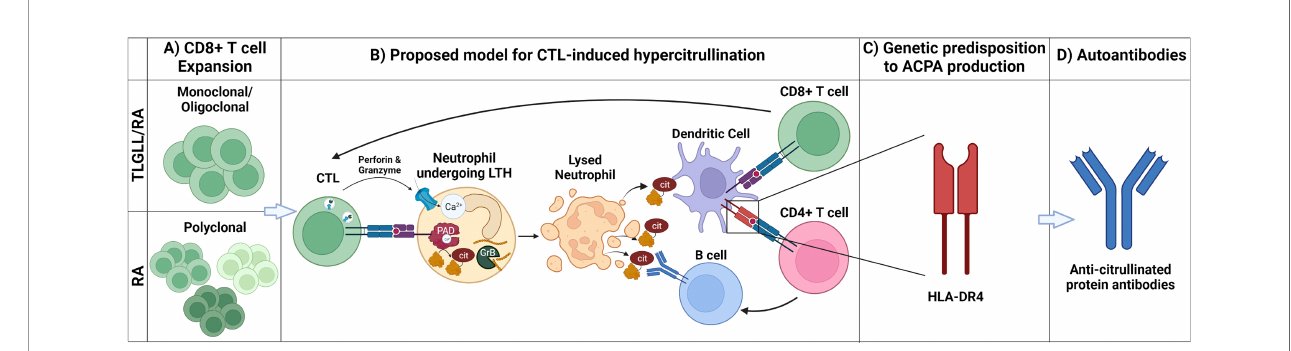
FIGURE 2 | Mechanistic parallels between T-LGL leukemia/RA and canonical RA. (A) CD8+ T cell expansion: T-LGL leukemia-associated RA (T-LGLL/RA) and canonical RA (RA) are characterized by the expansion of CD8+ T cells. The CD8+ T cell expansion is oligoclonal/monoclonal in T-LGLL/RA, whereas it is polyclonal in canonical RA. (B) Proposed model for CTL-induced hypercitrullination: In this model, clonally expanded CD8+ T cells (CTLs) targeting neutrophils release cytotoxic granules containing perforin and granzymes, inducing leukotoxic hypercitrullination (LTH). Perforin forms pores in the neutrophil membrane, allowing for calcium (Ca 2 + ) in fl ux and activation of intracellular PAD enzymes, inducing neutrophil hypercitrullination. In parallel, granzyme B (GrB) cleavage of neutrophil antigens creates neoepitopes. As a result of the disrupted cell membrane, the neutrophils lyse, releasing autoantigens, including citrullinated and GrB-cleaved proteins. Dendritic cells (DCs) engulf these antigens and present them both to CD8+ and CD4+ T cells. The stimulated CD8+ T cells clonally expand and drive a feedforward cycle of neutrophil damage. Stimulated CD4+ T cells provide B cell help, giving rise to antibody-secreting cells producing anti-citrullinated protein antibodies (ACPAs). (C) Genetic predisposition to ACPA production: ACPA production is facilitated by the presentation of citrullinated antigens via HLA-DRs (e.g., HLA-DR4) encoded by RA- associated HLA-DRB1 susceptibility alleles. The requirement of speci fi c RA-associated HLA-DRs for ACPA production likely explains why, despite having CTL expansion and neutrophil lysis, only a subset of patients with LGL leukemia develop RA. (D) Autoantibodies: Circulating APCAs are found in patients with T-LGLL/RA and canonical RA providing a serological record of the breach of immunologic tolerance to citrullinated antigens in both diseases. Created with